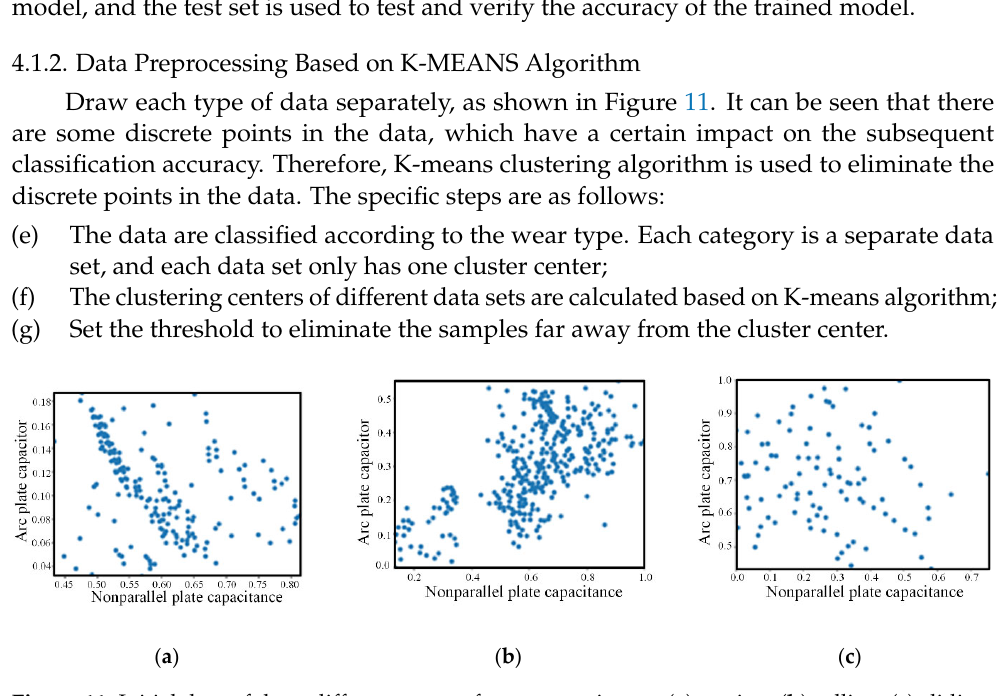
Figure 12. Three different types of wear capacitance data after pretreatment. ( a ) cutting; ( b ) rolling; ( c ) sliding.